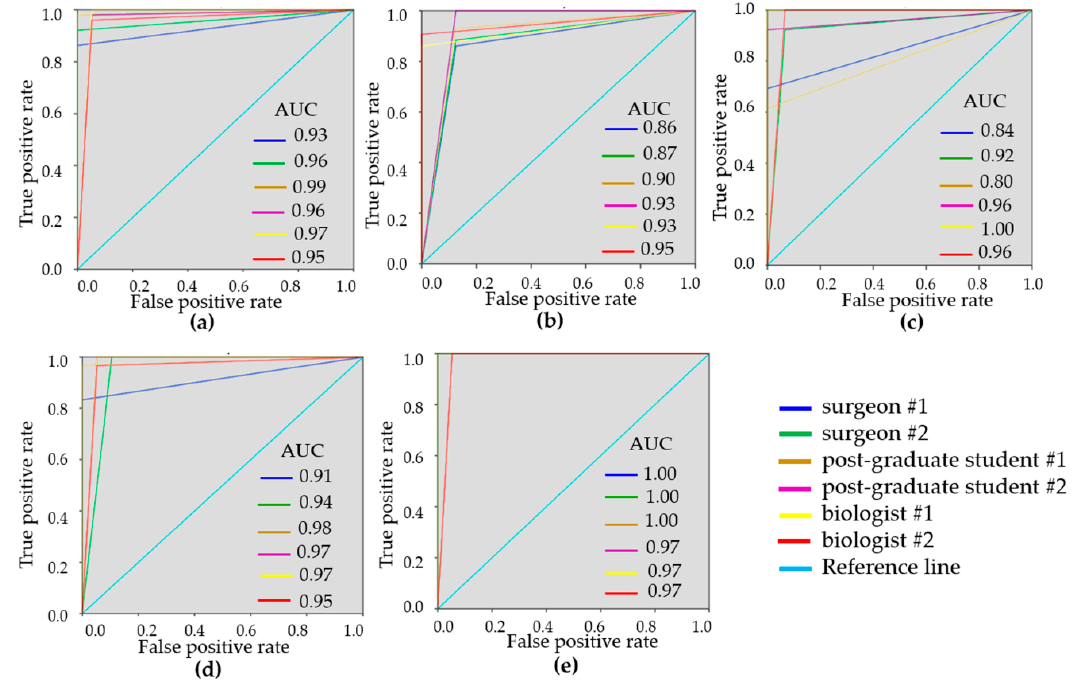
Figure 4. ROC-curves showing the results of visual assessment of C-OCE images for distinguishing non-tumorous from tumorous breast tissue ( a ), DCIS from invasive breast cancer ( b ), low-aggressive invasive breast cancer from highly-aggressive ( c ), non-tumorous breast tissue from low-aggressive breast cancer ( d ), non-tumorous breast tissue from highly-aggressive breast cancer ( e ) for six “blinded” readers.